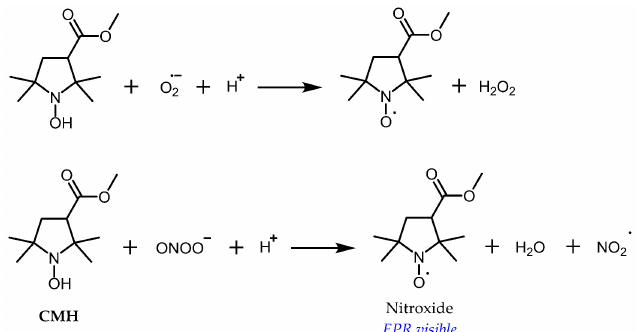
Figure 5. The principle of using hydroxylamines as probes for RONS. Electron-transfer reactions of 1-hydroxy-3-methoxycarbonyl-2,2,5,5-tetramethylpyrrolidine (CMH), the most often used hydroxylamine probe, with superoxide and peroxynitrite.